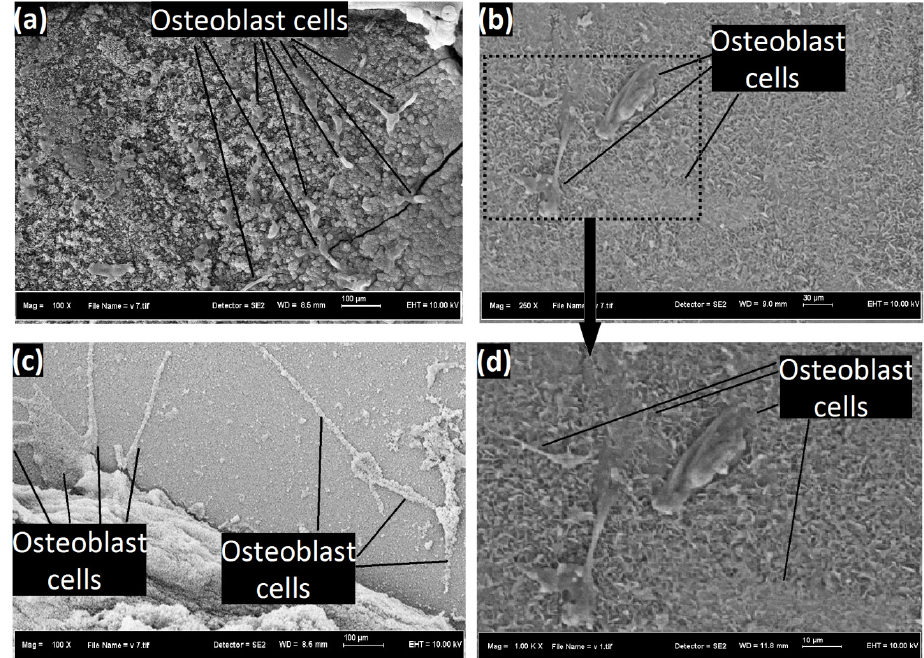
Figure 16. FE ‐ SEM micrographs of the cells cultured for 3 days on the surfaces of ( a ) uncoated, ( b ) MgO ‐ coated and ( c,d ) Si/MgO ‐ coated, which evidently indicate the adhered cells on the surfaces